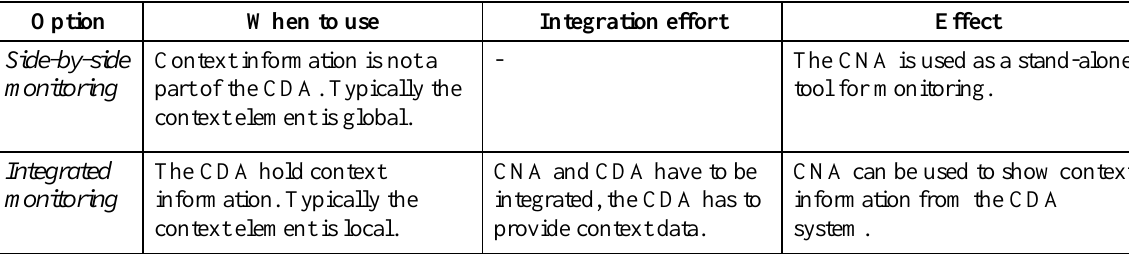
Table 4. Summary of run-time monitoring